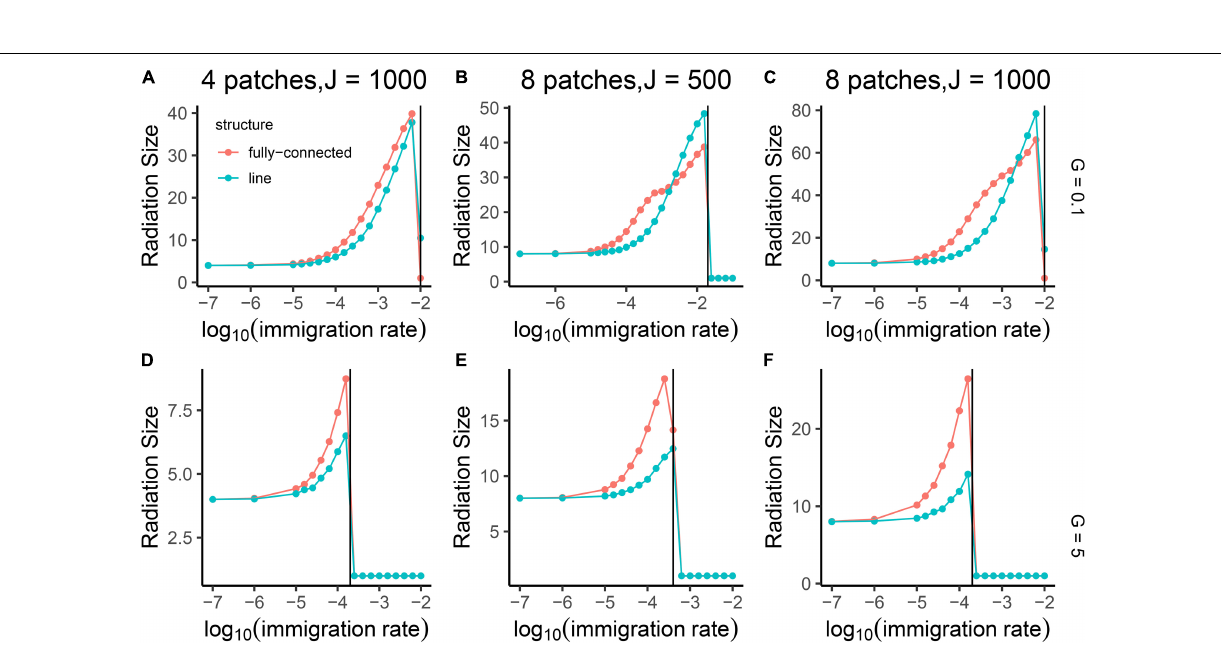
Frontiers in Ecology and Evolution |